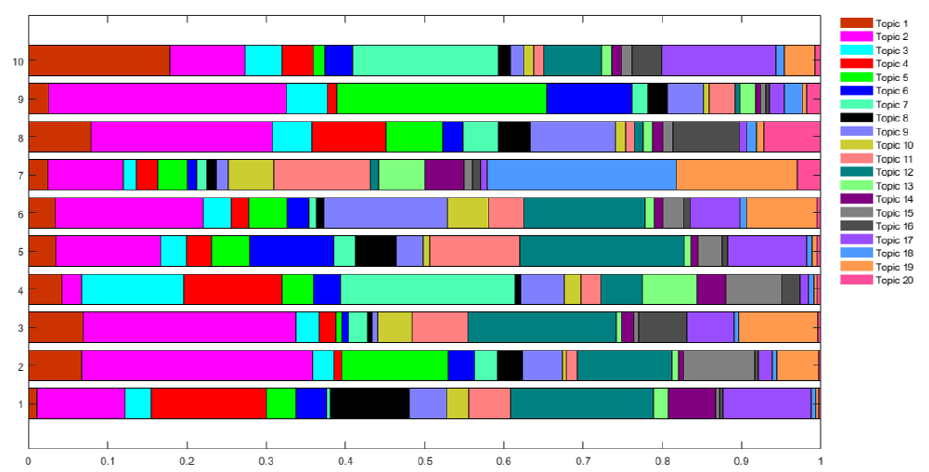
Figure 9. Topic probability for transcription from 1 to 10 in the set of